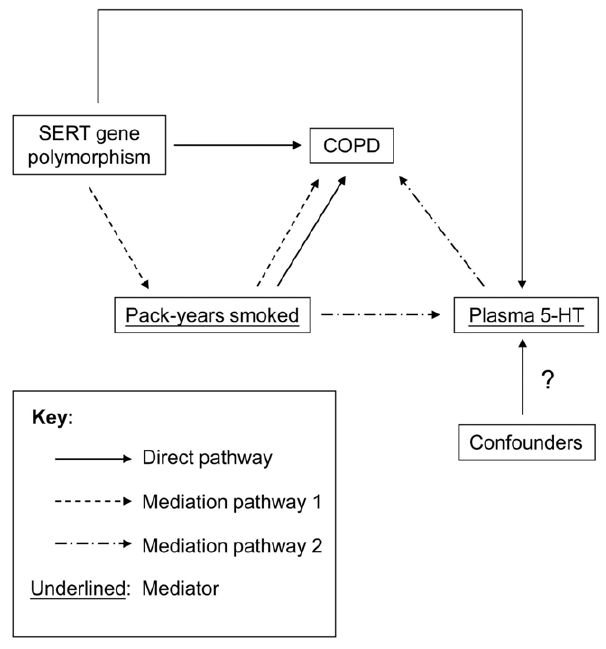
Figure 5. Hypothetic diagram for the relation among SERT gene polymorphism, plasma 5-HT, pack-years smoked and COPD. Pack-years smoked exert both direct and mediation effects on